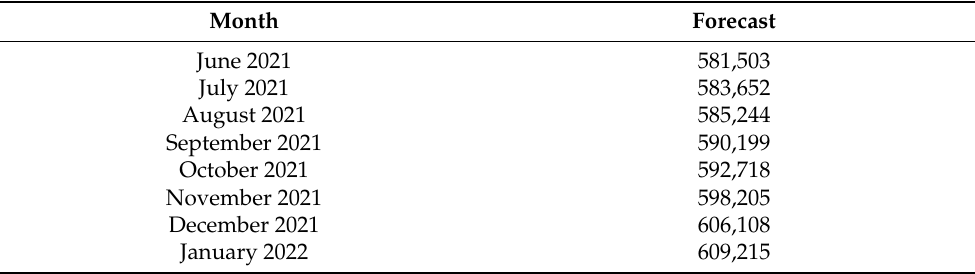
Table 4. Comparison of prediction accuracy with competing benchmark models.